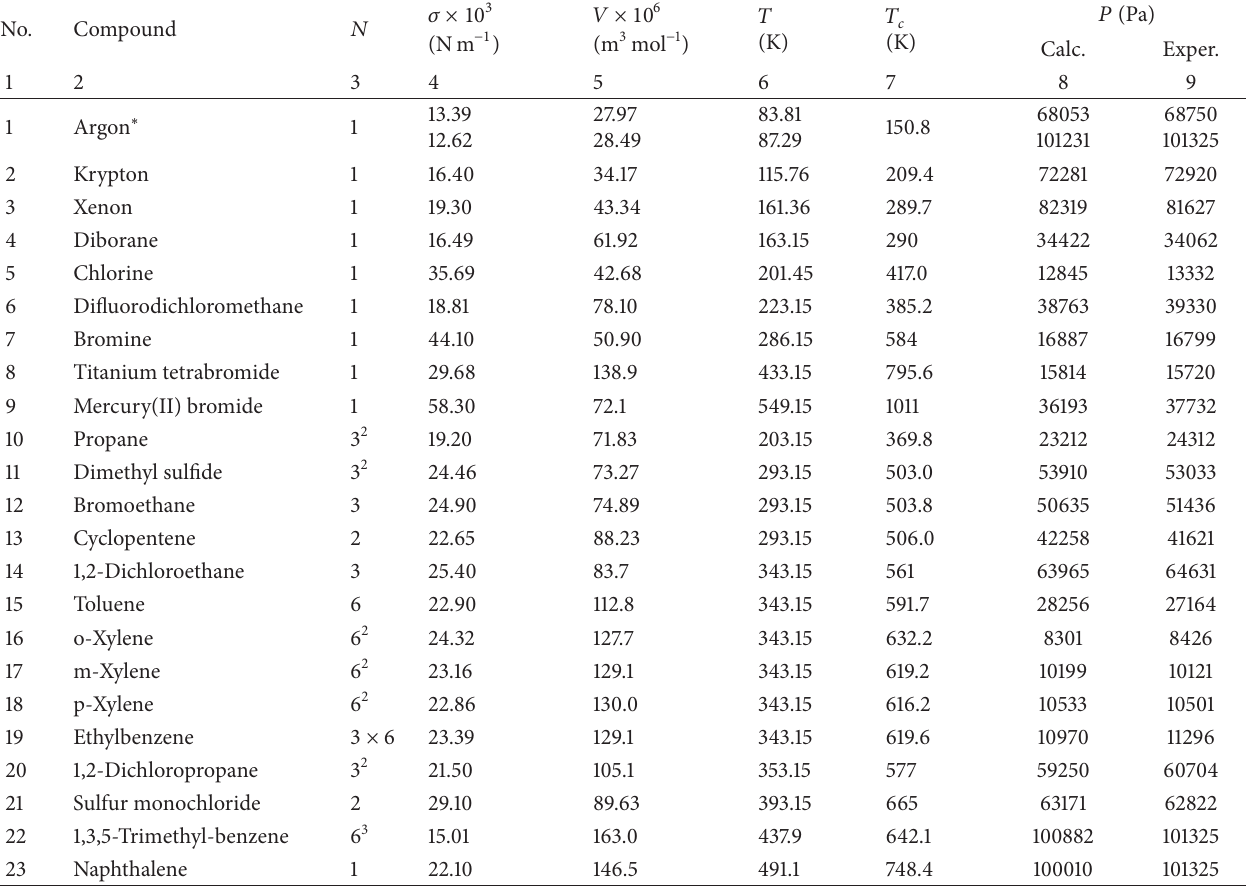
Table 4: The calculation of the quantity 𝑃 by means of